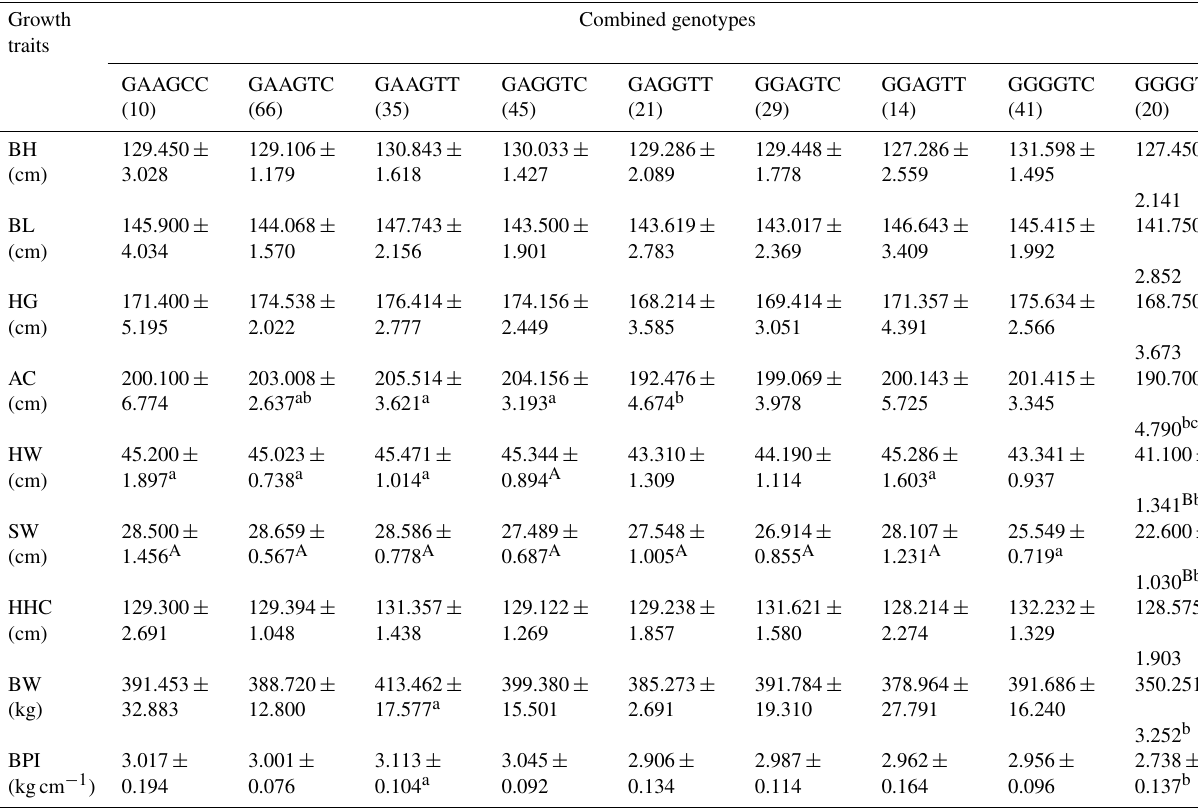
Table 3. Association analysis between combined genotypes of three SNPs in PPARD and growth traits of 300 adult cattle. Growth